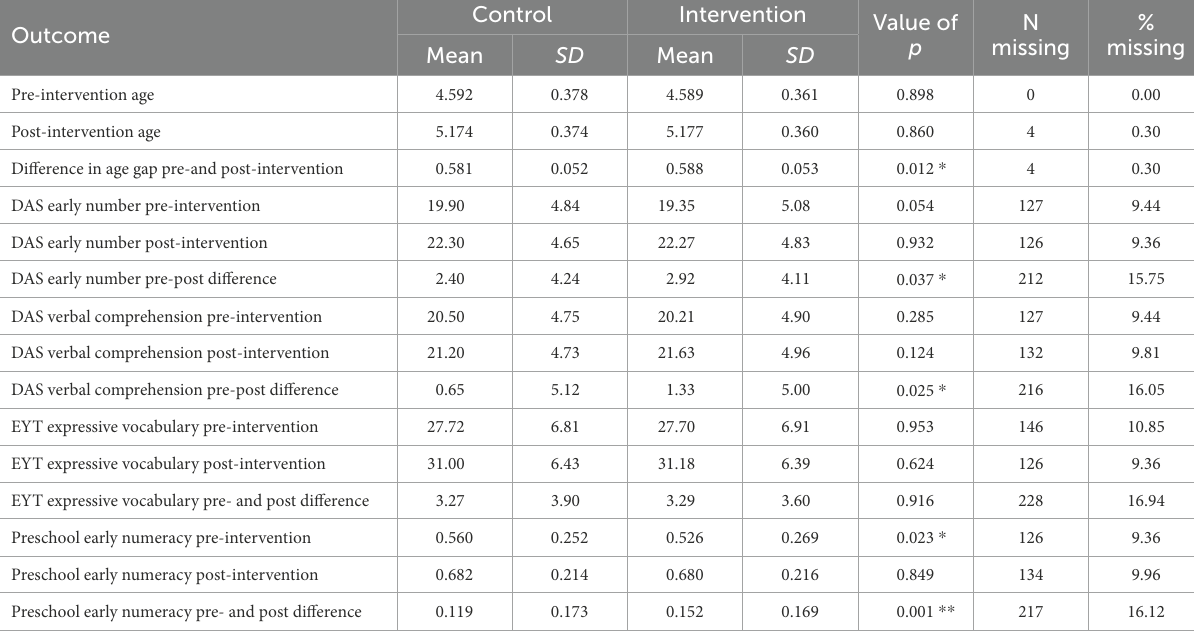
TABLE 6 Uncontrolled comparisons for age and outcome variables pre-and post-test difference by intervention/control